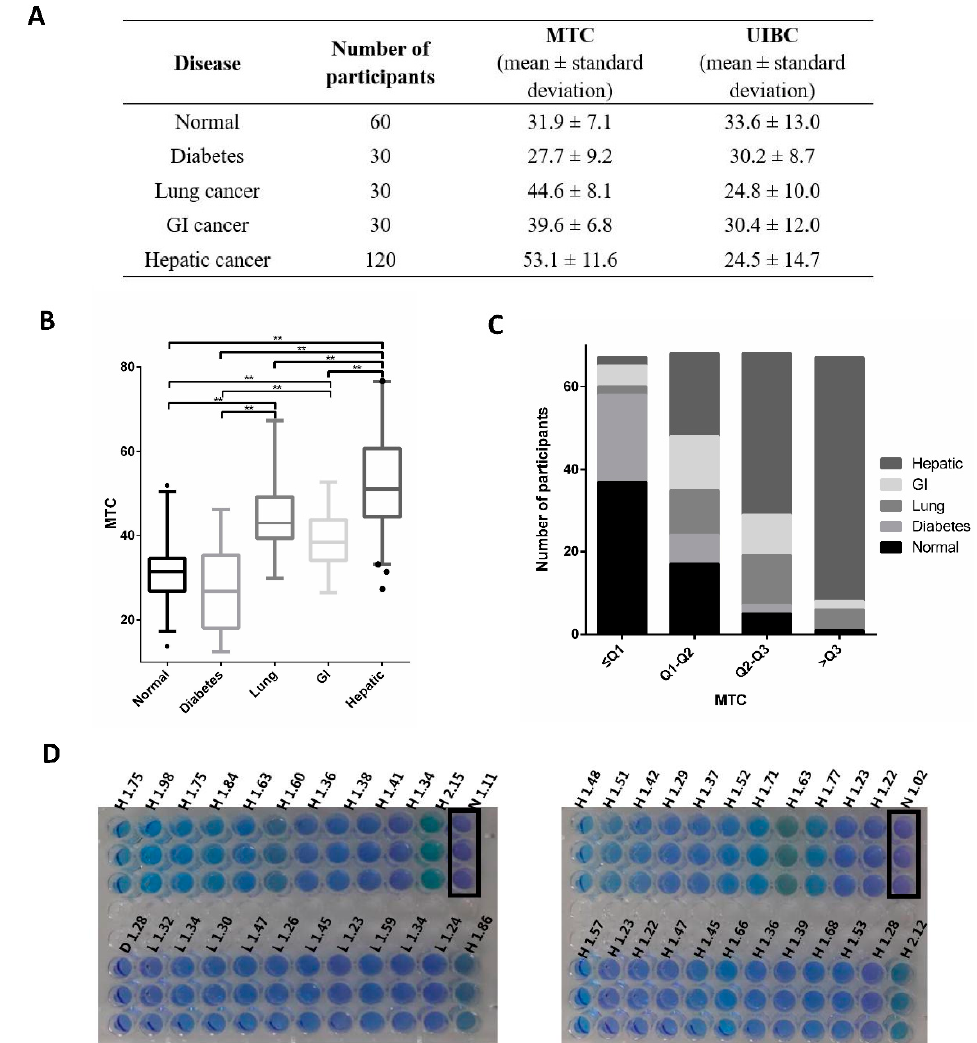
Figure 2. Systemic comparison between MTC and UIBC. ( A ) Comparison of concentration of apo-Tf obtained from MTC and UIBC for samples with different diseases and their corresponding sample size. Hepatic-disease patients were found with the highest concentration of apo-Tf obtained from MTC assay. ( B ) Distribution of MTC among normal subjects and patients with different types of disease. The boxes indicate interquartile ranges (IQRs) and the median (middle line). Whiskers extend to the most extreme points within 1.5-fold IQR. Outliers are plotted individually as dots. ** represents p values derived from Games–Howell test for multiple comparisons that are less than 0.001. ( C ) Distribution of subjects with different diseases in four quartile intervals of apo-Tf obtained from MTC assay. Q1, Q2 and Q3 illustrate the first (33.296), second (41.767) and third quartile (51.783) of MTC, respectively. ( D ) Colorimetric feature of MTC assay. Samples from normal group (abbreviated as N and highlighted by black square) shows purple color due to the lower A660 reading. In contrast, samples from patients with hepatic cancer (abbreviated as H) have higher A660 reading which resulted in more green colors. Lung cancer and diabetic samples are labelled as L and D,